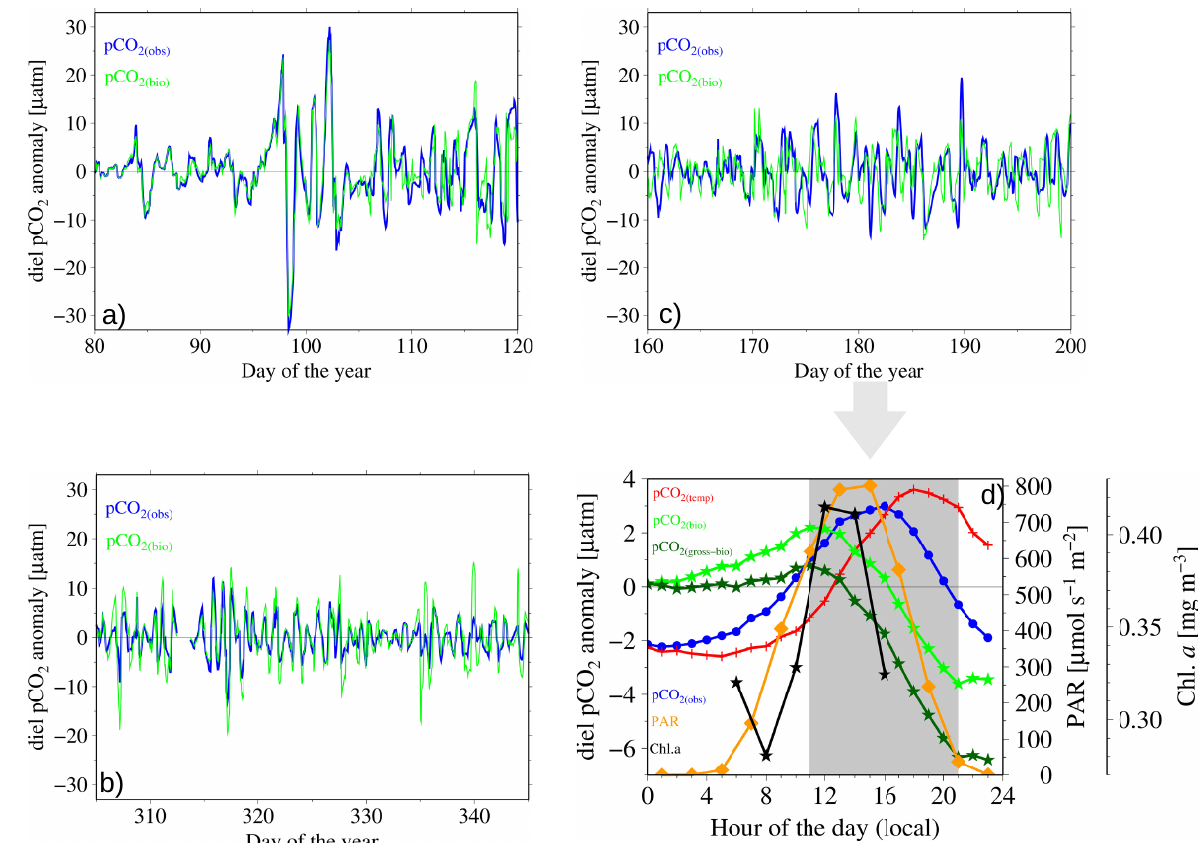
Thomas et a., Fig. 4 Fig. 4. Diel anomalies and daily cycles of observed p CO 2 , biologically controlled p CO 2 , PAR, and Chl a . We show diel anomalies of p CO 2, obs (blue) and p CO 2, bio (green) for three periods of the year ( a – c ) as depicted in Fig. 1. Note the phase shift in the warming period ( c , d ), while outside the warming period ( a , b ) both parameters show the same timing (i.e. they are independent). Average diel anomalies or daily cycles compiled for the 40-day period from days 160–200, representative for the warming period (see Fig. 1), for observed p CO 2 ( p CO 2, obs , blue), biologically controlled p CO 2 ( p CO 2, bio , green), temperature-only controlled p CO 2 ( p CO 2, temp , red), p CO 2, bio corrected for respiratory activity ( p CO 2, gross-bio , dark green) and photosynthetic active radiation (PAR, orange). Chlorophyll a (Chl a , black) is shown for the hours (6.00h–16.00h), when reliable E d (λ) measurements can be made by the SeaHorse. The grey-shaded box indicated the period, when net carbon fixation occurs. Note that p CO 2, temp reflects the daily cycle of temperature. The respiration rate has been computed from the slope of the p CO 2, bio during nighttime conditions. The production rates have been computed from the slopes of p CO 2, bio and p CO 2, gross-bio during daytime (grey-shaded area), respectively. The time scale reveals local time, i.e. GMT − 3h.